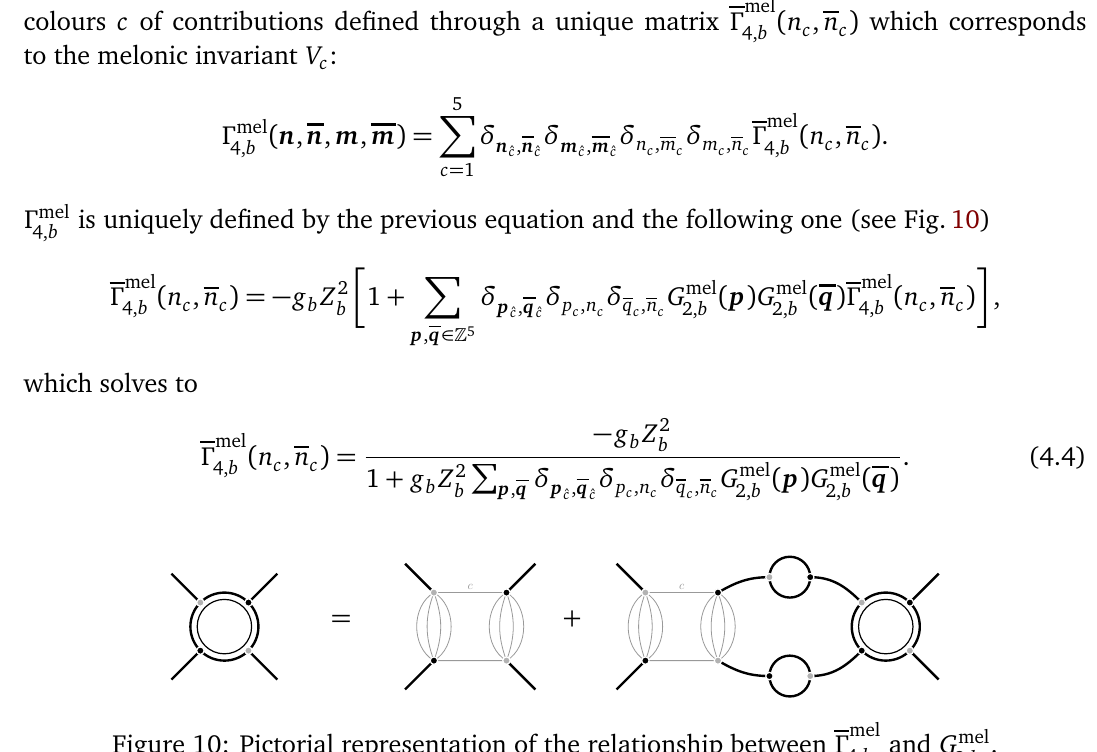
Figure 10: Pictorial representation of the relationship between Γ